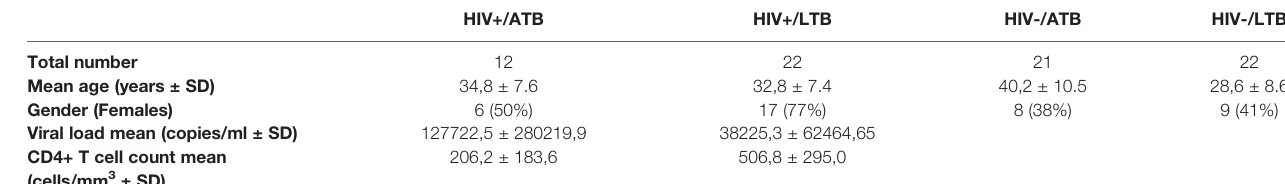
TABLE 1 | Demographic data and HIV-associated